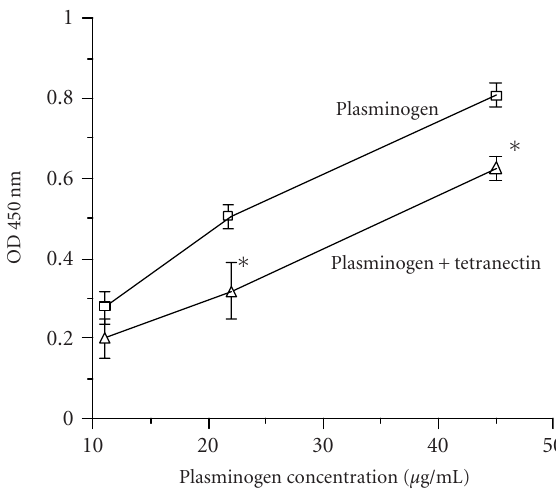
Figure 1. Binding of plasminogen or AST K1-4 to tetranectin. ELISA plates were coated with recombinant wild-type human tetranectin (100 nM) or BSA, and then treated with plasmino- gen (22.5 µ g/mL) and AST K1-4 (50 µ g/mL). Results shown are mean ± SEM of 5 experiments (each experiment done in trip- licate). Binding of plasminogen and AST K1-4 to tetranectin was significantly greater than binding to BSA-coated plates ( P < . 01).